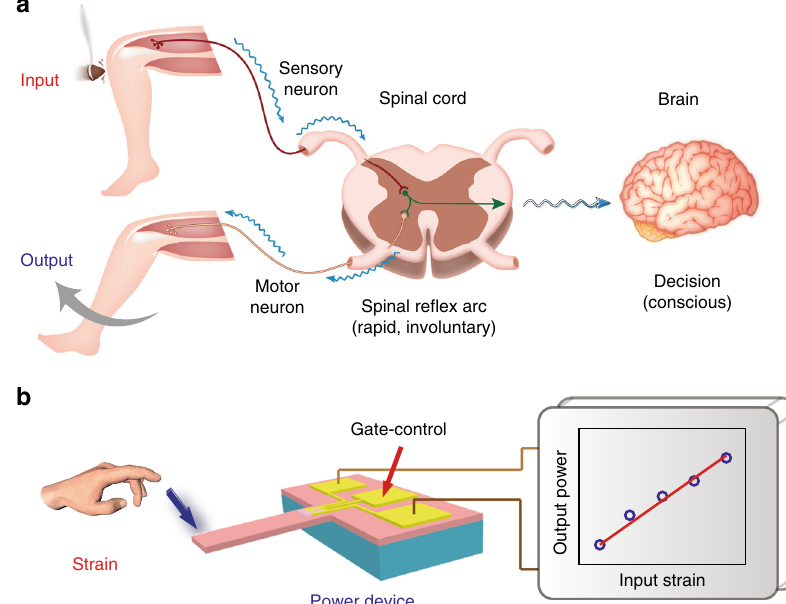
Fig. 1 Concept of strain-controlled power device (SPD) as inspired by human re fl ex. a Schematic illustration of human re fl ex. When a stimulus is received from a thigh muscle at the knee, the action potential in the sensory neuron is sent to the gray matter of the spinal cord. The sensory neuron in the spinal cord directly establishes a synaptic connection with the motor neuron. If the signal is strong enough, it can trigger action potentials in motor neuron, causing knee re fl ex. Moreover, knee re fl ex is a spinal re fl ex whose re fl ected nerve center is in the spinal cord, but is still modulated by the high central nervous system (brain). b Schematic illustration of the SPD. The external strain applied to the cantilever-based power device can emulate the logic process of human re fl ex to control the output power with the input mechanical stimulus.